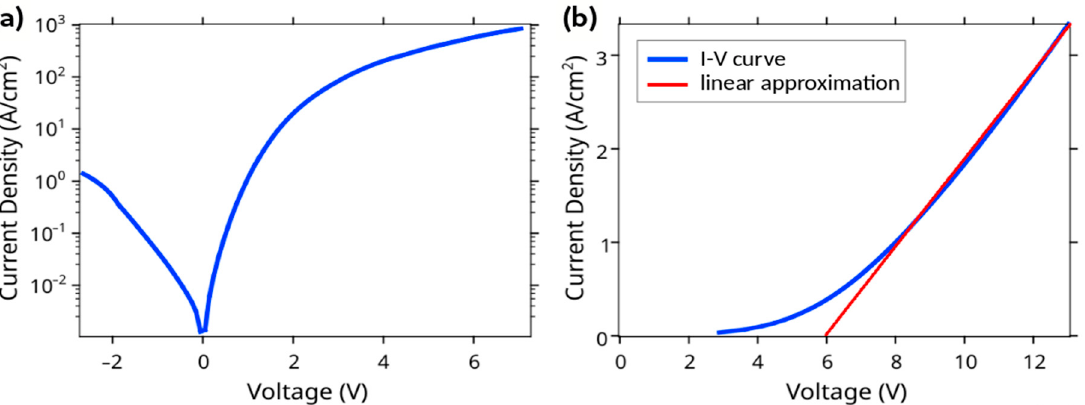
Figure 5. I-V characteristics of the ( a ) test n-GaN NWs-based structure and ( b ) n-GaN/i-InGaN/GaN NWs-based LED on Si.